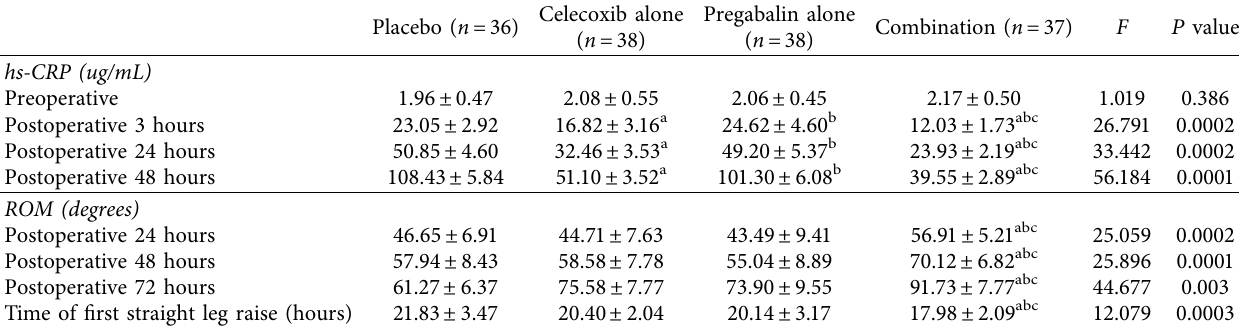
Table 3: hs-CRP level and knee functional indicator.